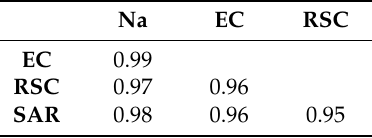
Table 8. Correlation between irrigation water quality